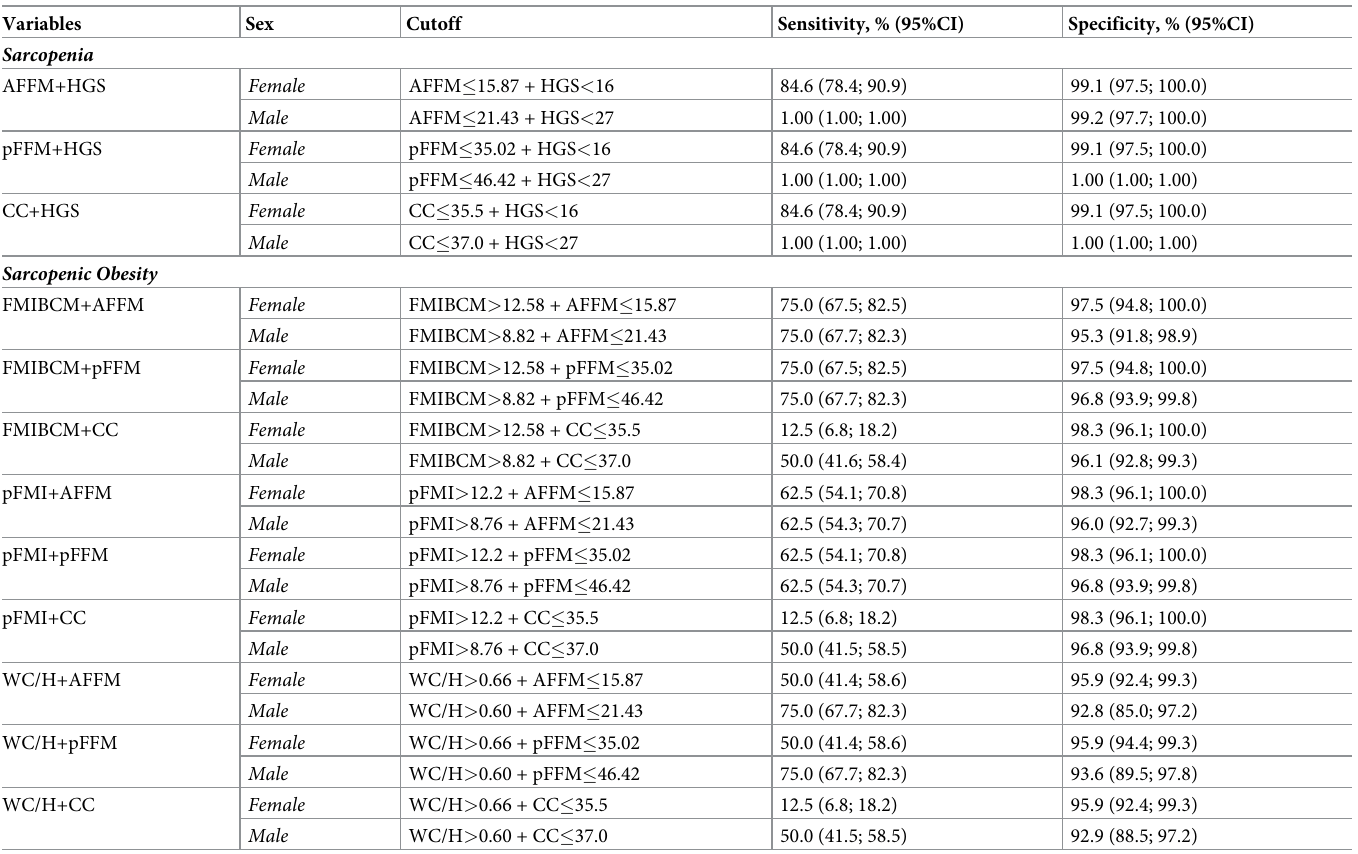
Table 5. Sensitivity and specificity of bed-side measures/indexes to identify sarcopenia 1 and sarcopenic obesity 2 .